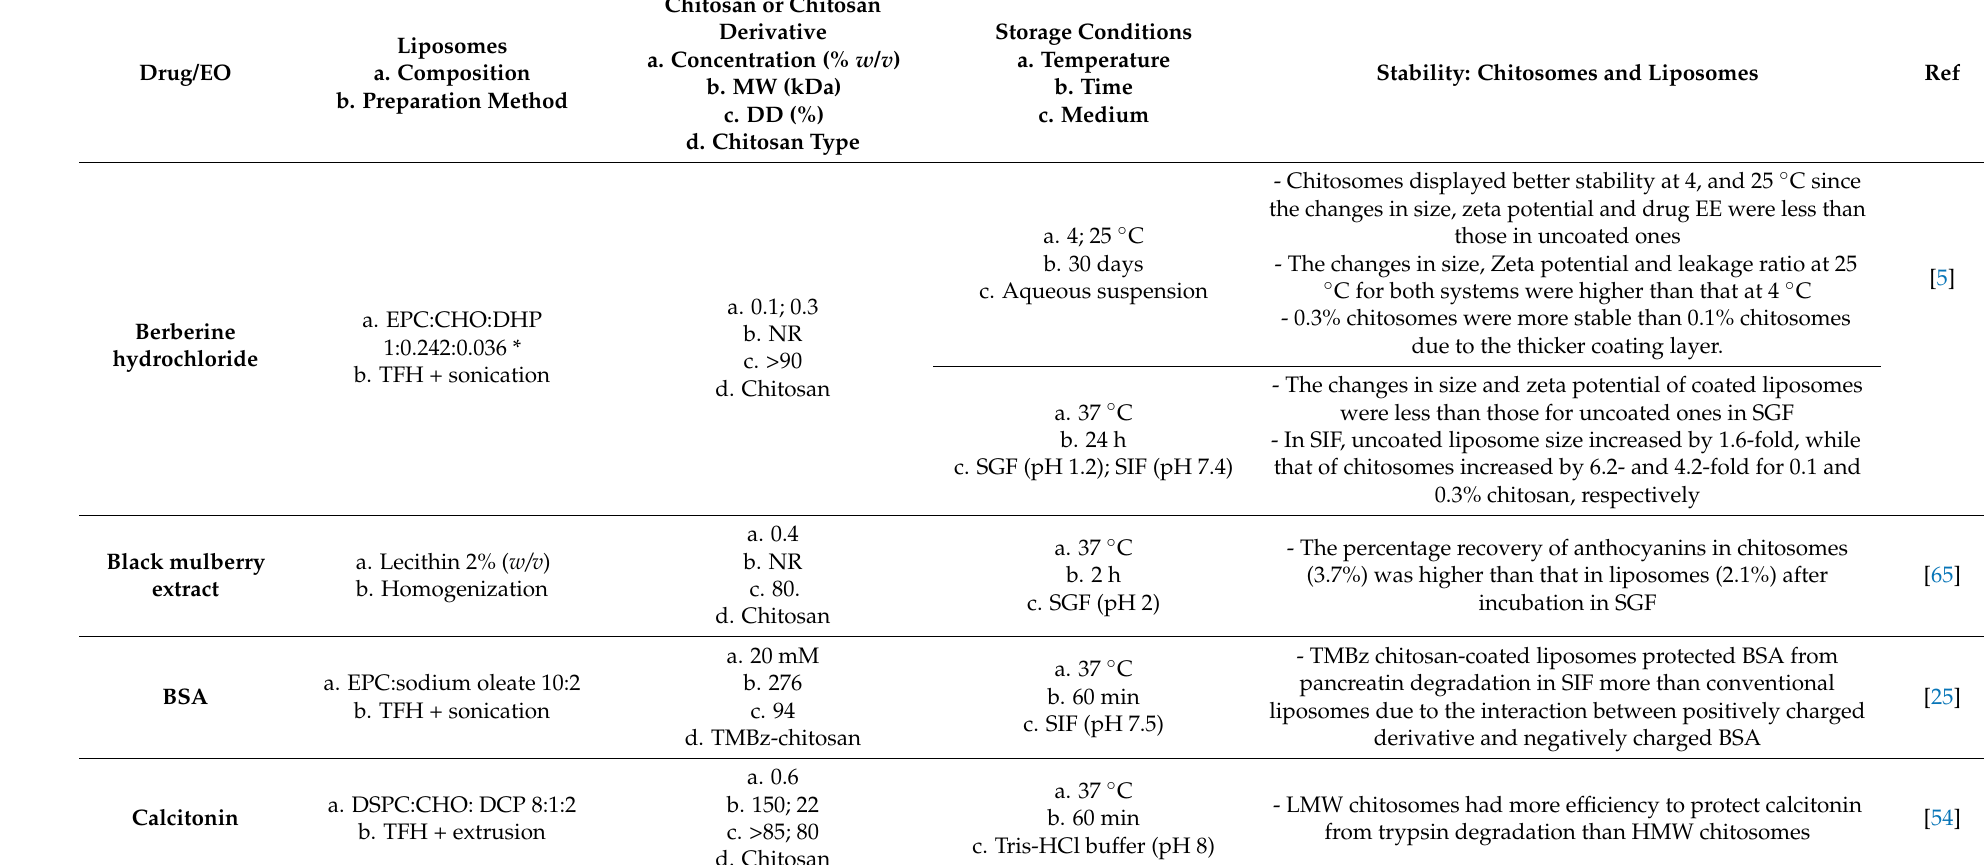
Table 6. Comparison of stability between drug-loaded liposomes and drug-loaded chitosomes under various conditions. The liposomal composition is indicated in the table in molar ratio except when * exists, indicating a weight ratio ( w/w